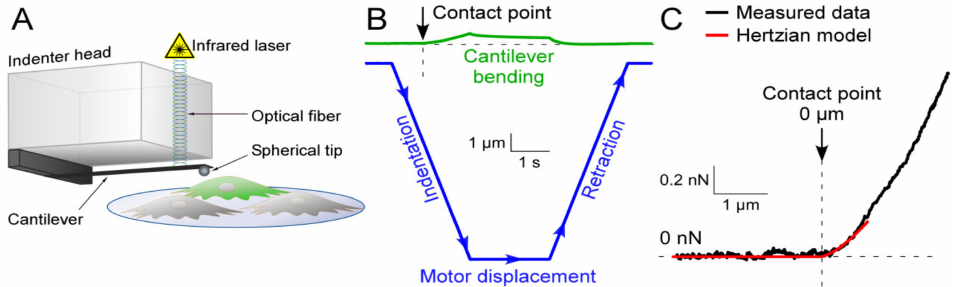
Figure 1. Measuring cell stiffness by nanoindentation: Principle, protocol, and recording. ( A ) nanoindenter used to measure resistance to deformation (stiffness). A spherical glass tip attached to a cantilever of known stiffness is used to indent a sample, e.g., a cell. Cantilever deformation is measured interferometrically and used to calculate the force applied to the sample. Green cell: Transfected cell expressing enhanced green fluorescent protein (EGFP) alone, or EGFP and the gene of interest. ( B ) downward movement of the indenter (motor displacement) beyond the cell surface leads to indentation of the cell and to cantilever bending. ( C ) force vs. indentation curves can be fitted using a Hertzian model for contact mechanics enabling to derive the effective Young’s modulus E eff , which is 0.15 kPa in this